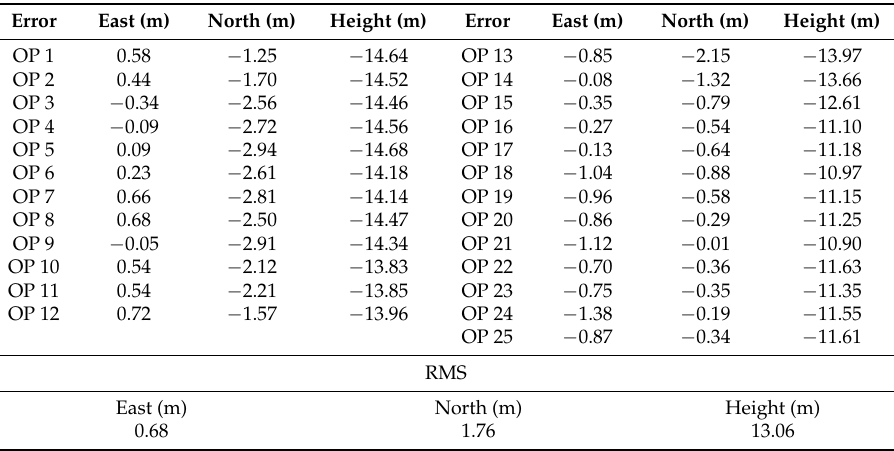
Table 4. The determined absolute accuracy of the initial Object Points